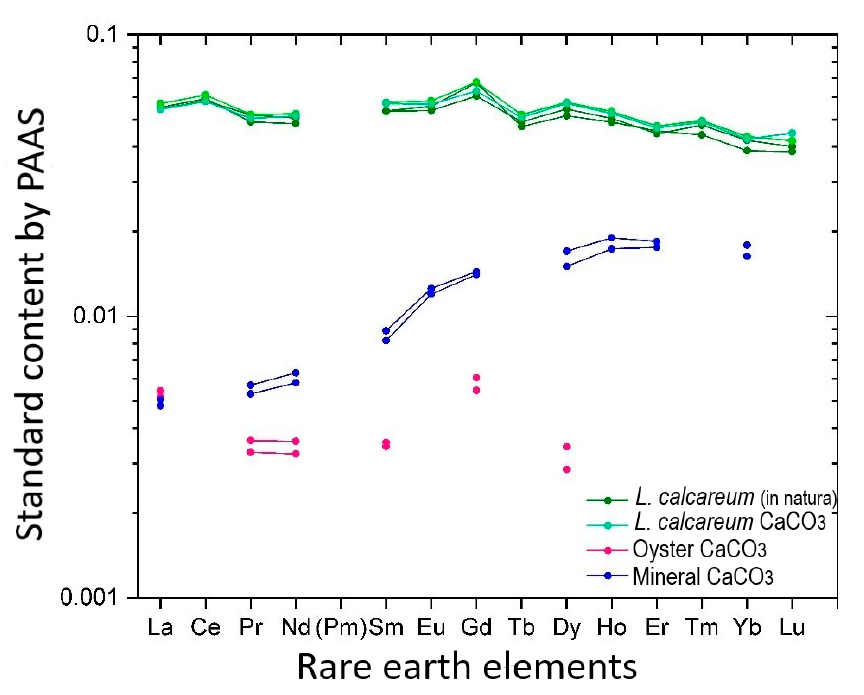
Figure 8. Patterns of rare earth elements (REE) from the three CaCO 3 samples, normalised by the average composition of the earth’s crust [56].